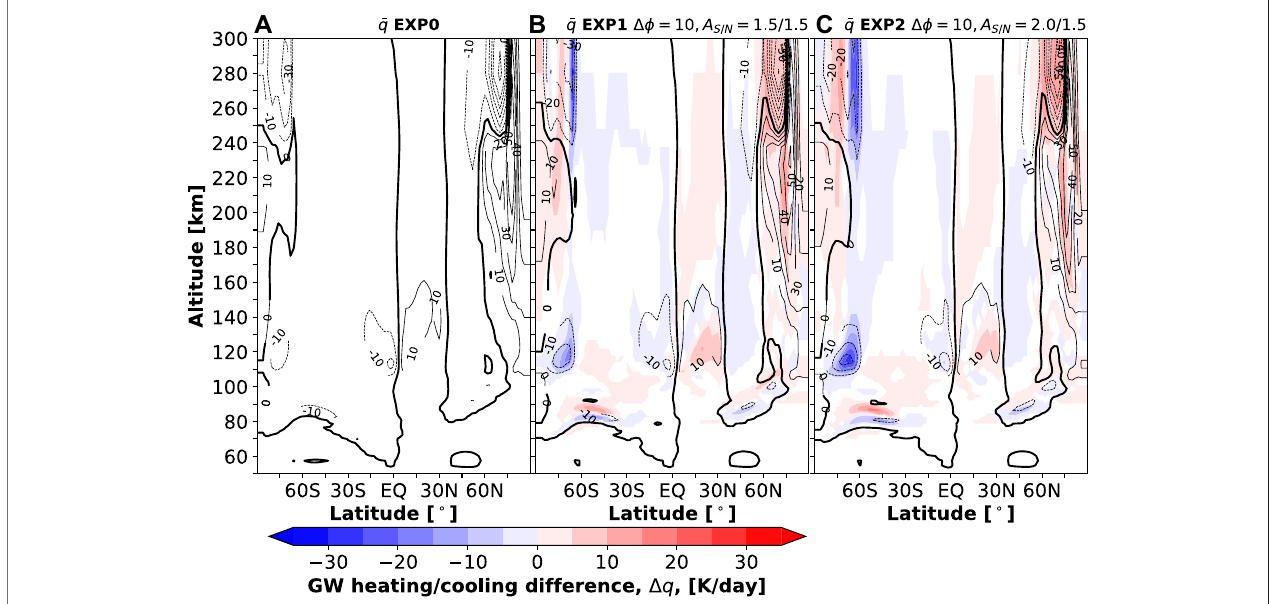
FIGURE8| Panels (A) – (C) arethesameasin Figure4 ,butfortheGWheating/coolingrates.Thecontourintervalsare10 Kday − 1 between ± 50Kday − 1 and20 K day − 1 for values with magnitudes larger than 50 K day − 1